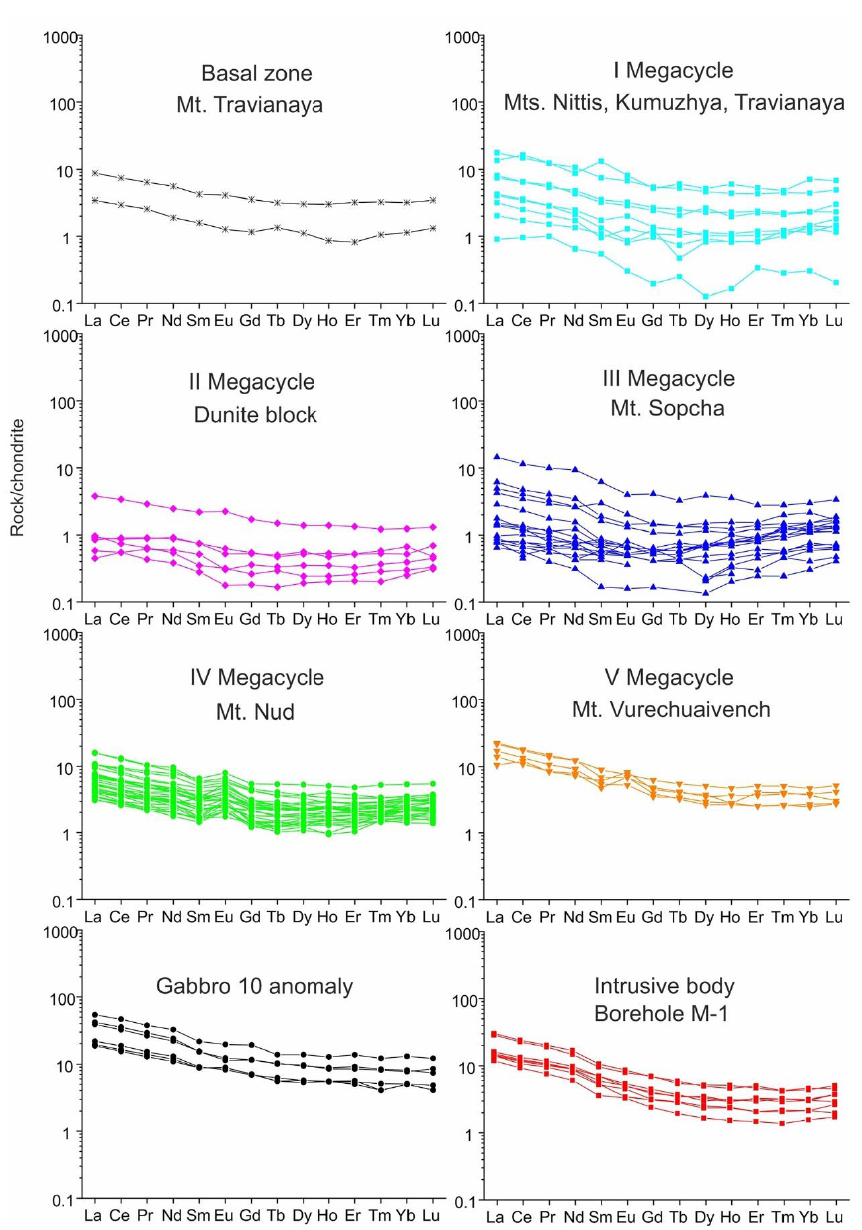
Figure 8. REE distribution of rocks in the Monchepluton and intrusive body normalized to chondrite [33].